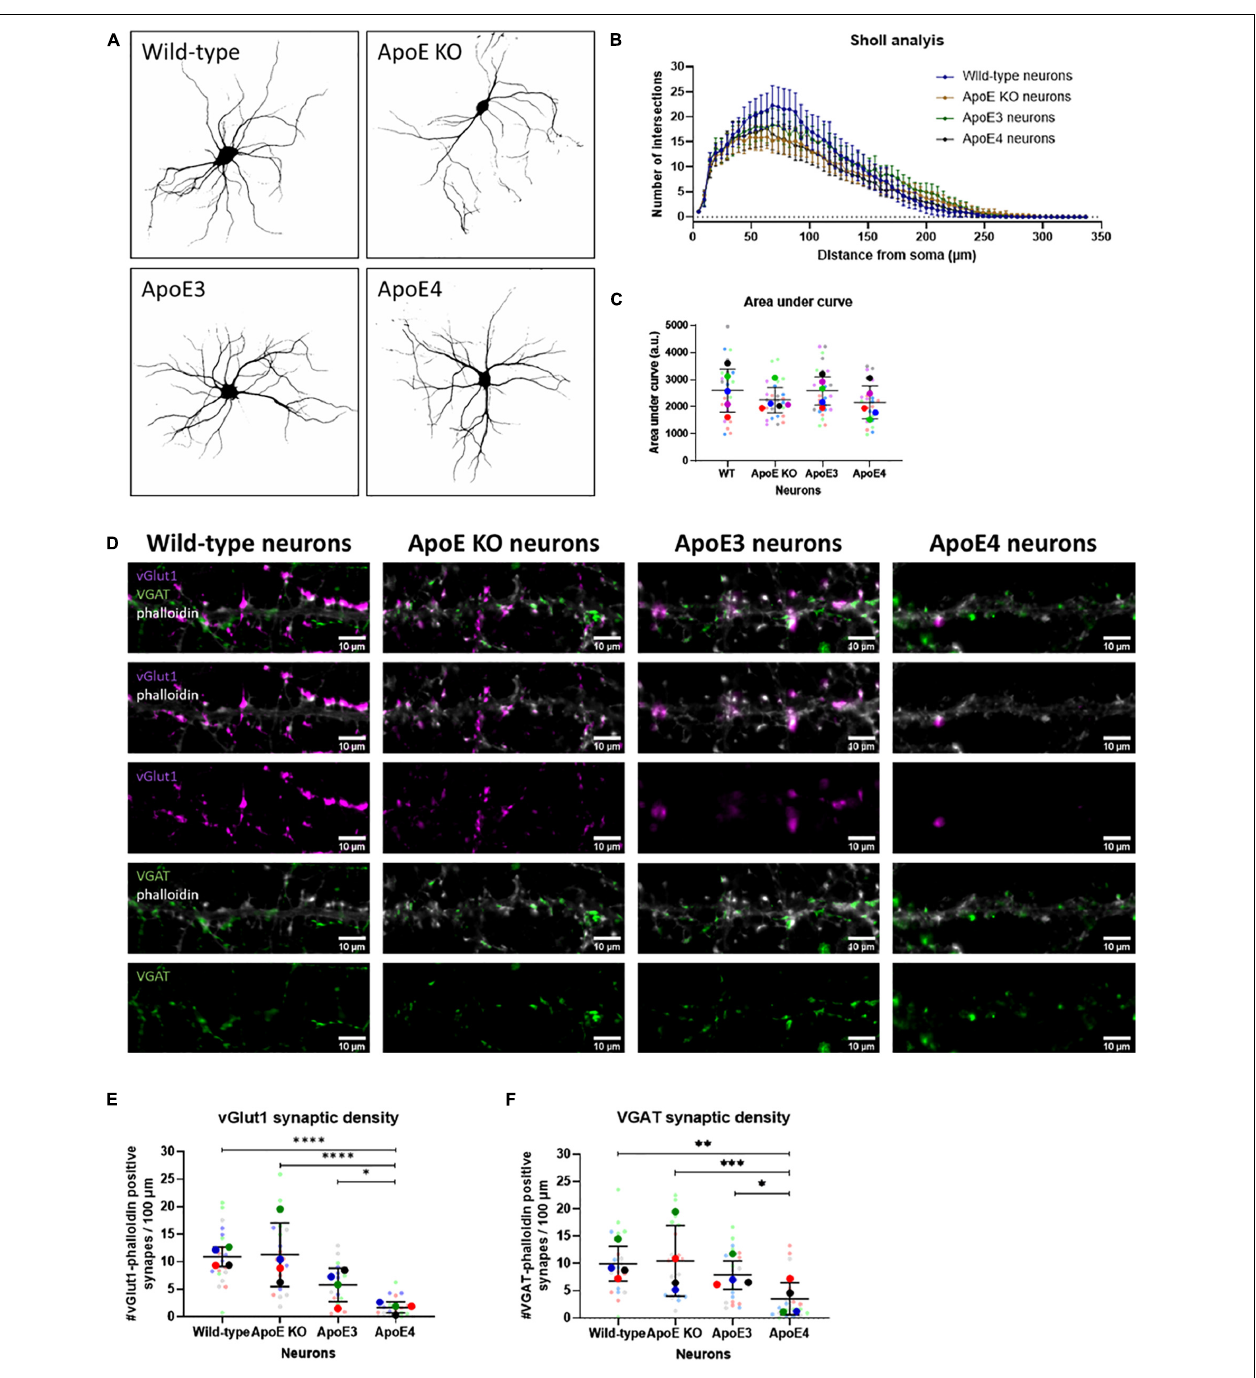
FIGURE 5 | Neuronal ApoE4 reduces synaptic density, but not dendritic branching. (A) Representative binary images obtained by epifluorescence microscopy of wild-type, ApoE KO, ApoE3 and ApoE4 primary neurons (19 DIV). Neurons were labeled for neuronal/dendritic marker MAP2. (B) Graph showing Sholl analysis results of wild-type, ApoE KO, ApoE3 and ApoE4 neurons ( N = 5 embryos per conditions, n = 25 neurons per condition). Data are shown as mean ± 95% CI. (C) Quantification of area under the curve of Sholl analysis data shown in panel (B) of wild-type, ApoE KO, ApoE3 and ApoE4 neurons ( N = 5 embryos per condition, n = 25 neurons per condition). Statistical analysis was performed using one-way ANOVA. Data are shown in a superplot including mean ± SD of each condition. (D) Representative microscopy images of excitatory vGlut1-positive (magenta) and inhibitory VGAT-positive (green) presynapses in phalloidin-labeled (gray) neurons in wild-type, ApoE KO, ApoE3 and ApoE4 neurons (19 DIV). Scale bar represents 10 µ m. (E,F) Quantification of vGlut1-phalloidin synaptic density (E) and VGAT-phalloidin synaptic density (F) in wild-type, ApoE KO, ApoE3 and ApoE4 neurons ( N = 4 embryos per condition, n = 20 neurons per condition). Superplots represent all data points of each analyzed embryo and neuron. Data are shown as mean ± SD. Kruskall Wallis tests in combination with Dunn’s test were used to analyze statistical differences. * p < 0.05; ** p < 0.01; *** p < 0.001; **** p < 0.0001.